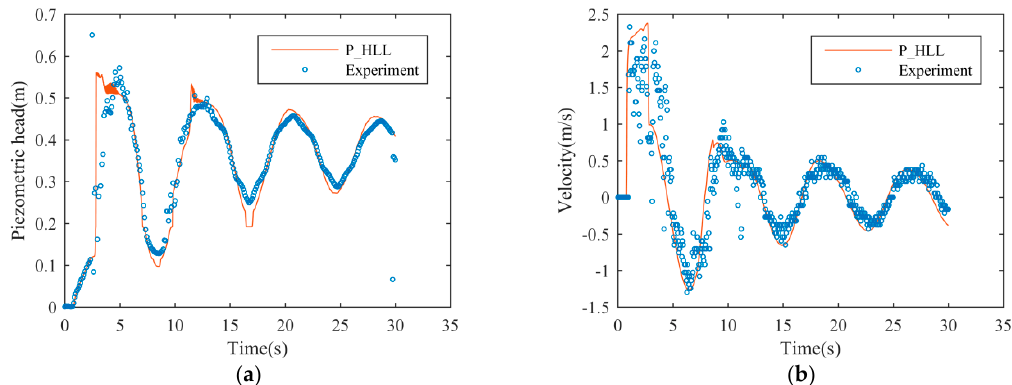
Figure 24. Locus of flow states at x = 6.8 m simulated by P_HLL ( P a = 4 and P b = 0.7) and experimental data: ( a ) piezometric head; ( b ) flow velocity.